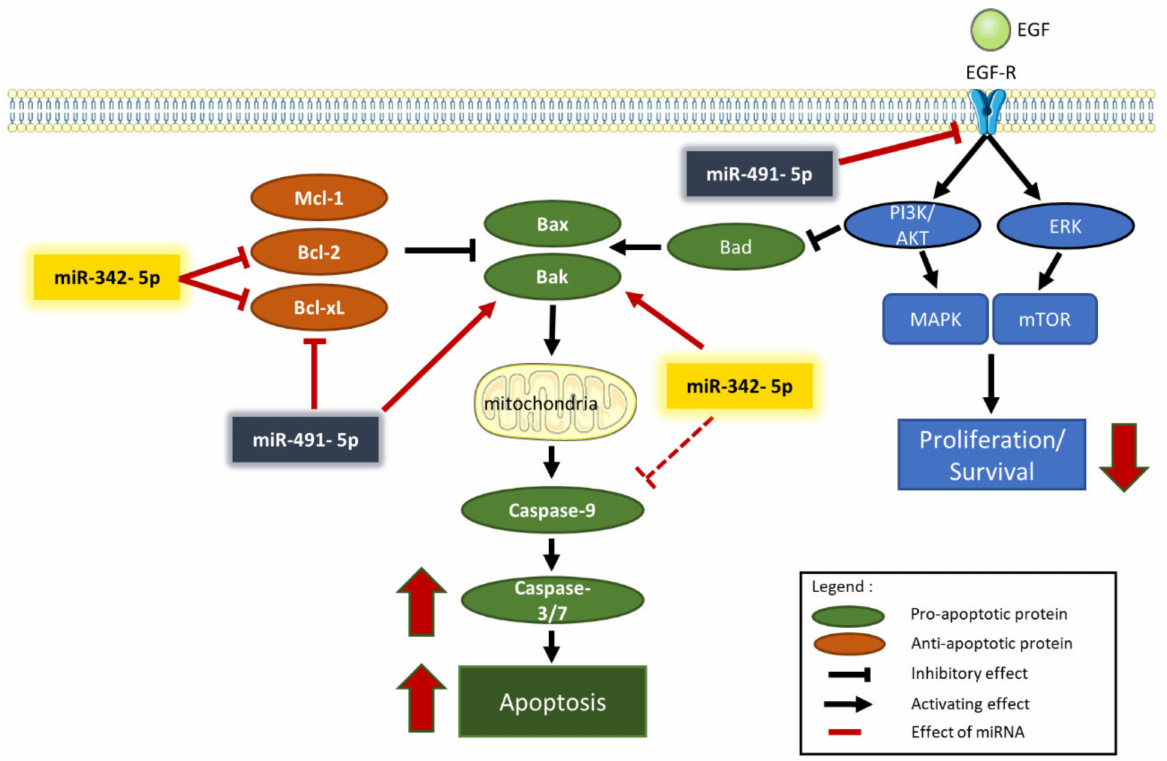
Figure 7. Overview of the mechanisms of action of miR-491-5p and miR-342-5p in human osteosar- coma